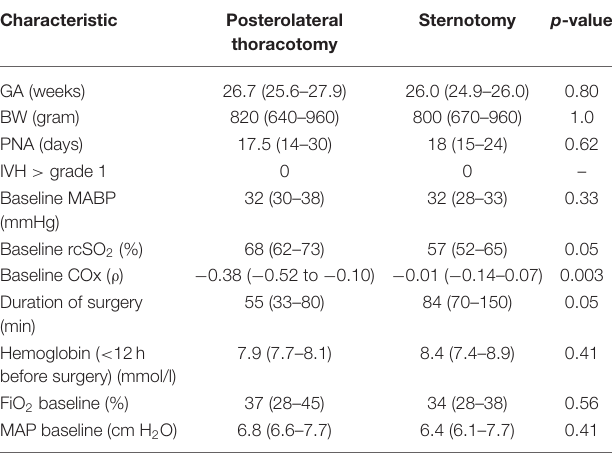
TABLE 1 | Baseline characteristics of the infants that underwent ductal ligation via posterolateral thoracotomy or via sternotomy. Characteristic